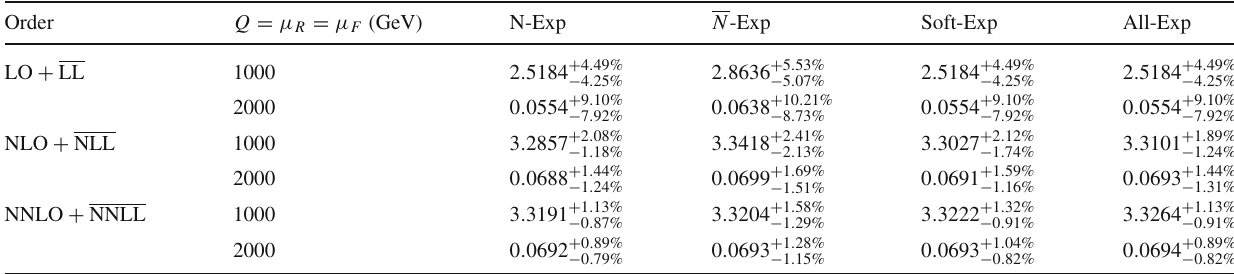
Table 12 Resummed results for invariant mass distribution of di-lepton pair against fixed-order (in pb/GeV) at different centre of mass energies at the LHC for Q = 200 GeV √ S NNLO NNLO + NNLL NNLO + NNLL 7 TeV